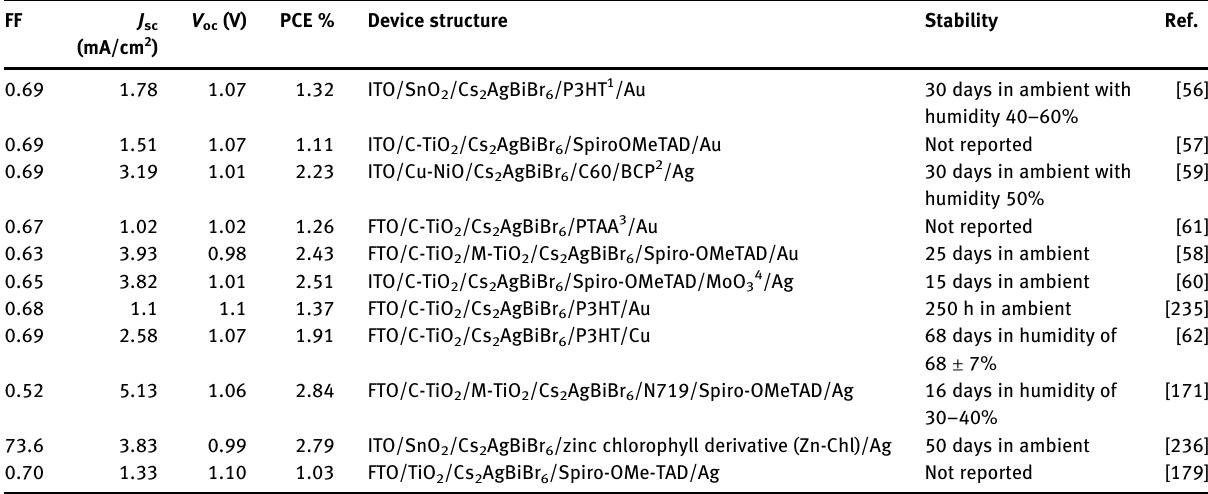
Table  : Summary of the photovoltaic parameters of the MHDP solar cells. FF Device structure